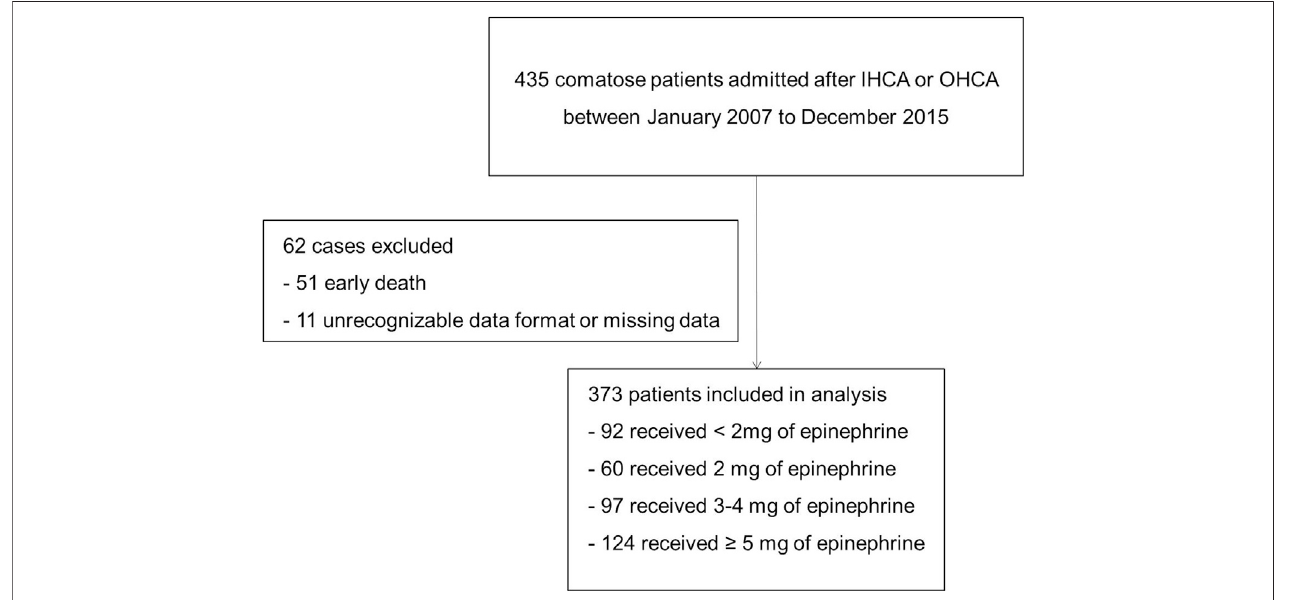
FIGURE 1 | Flowchart of patient selection. Abbreviation: IHCA, in-hospital cardiac arrest; OHCA: out-of-hospital cardiac arrest.